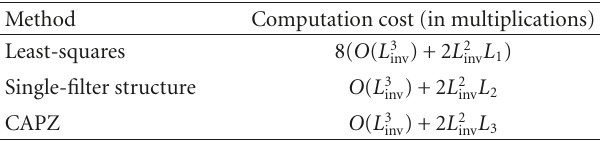
Table 2: Computational complexity of crosstalk cancellation filter estimation for the three methods: the least-squares method, the single-filter structure method, and the CAPZ